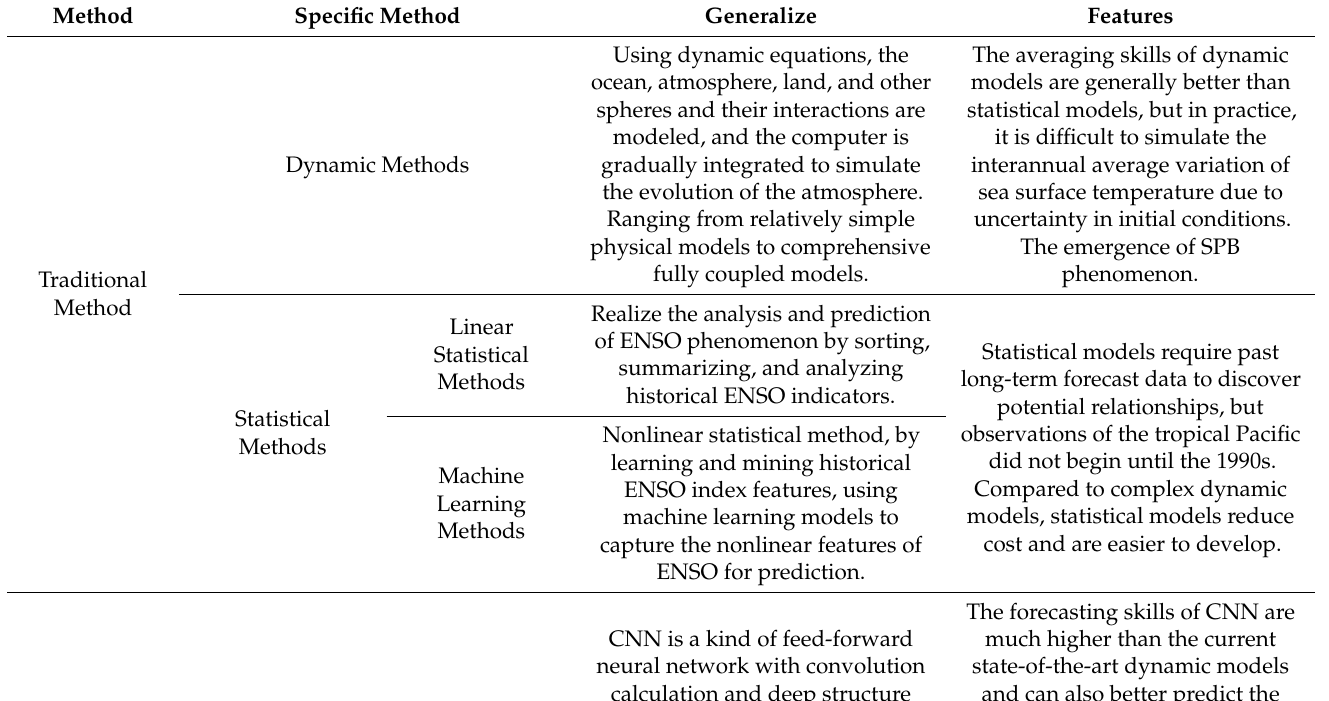
Table 1. Summary of deep learning and its application in ENSO